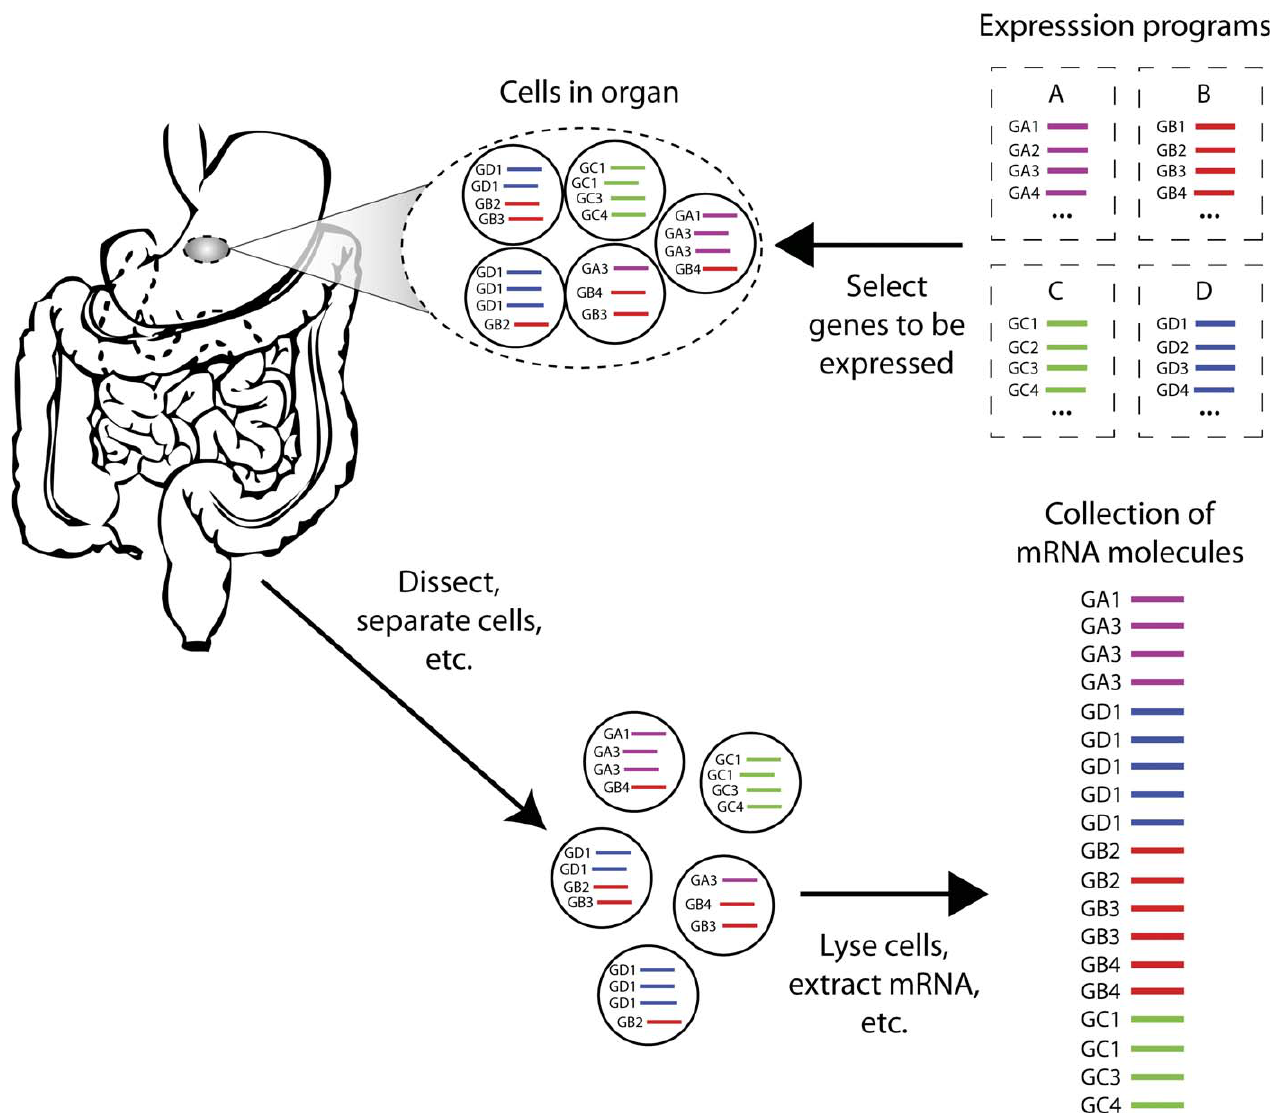
Figure 2. Conceptual Overview of the Data Generation Process for Gene Expression in Human Tissues The GeneProgram probability model can be thought of as a series of ‘‘ recipes ’’ for constructing the gene expression of tissues, as depicted in this schematic example for a digestive tract. In the upper right, four expression programs (labeled A–D) are shown, consisting of sets of genes (e.g., GA1 represents gene 1 in program A). Cells (circles) throughout the digestive tract choose genes to be expressed probabilistically from the programs. The biological experimenter then collects mRNA by dissecting out the appropriate tissue sample, homogenizing it, lysing cells, and extracting nucleic